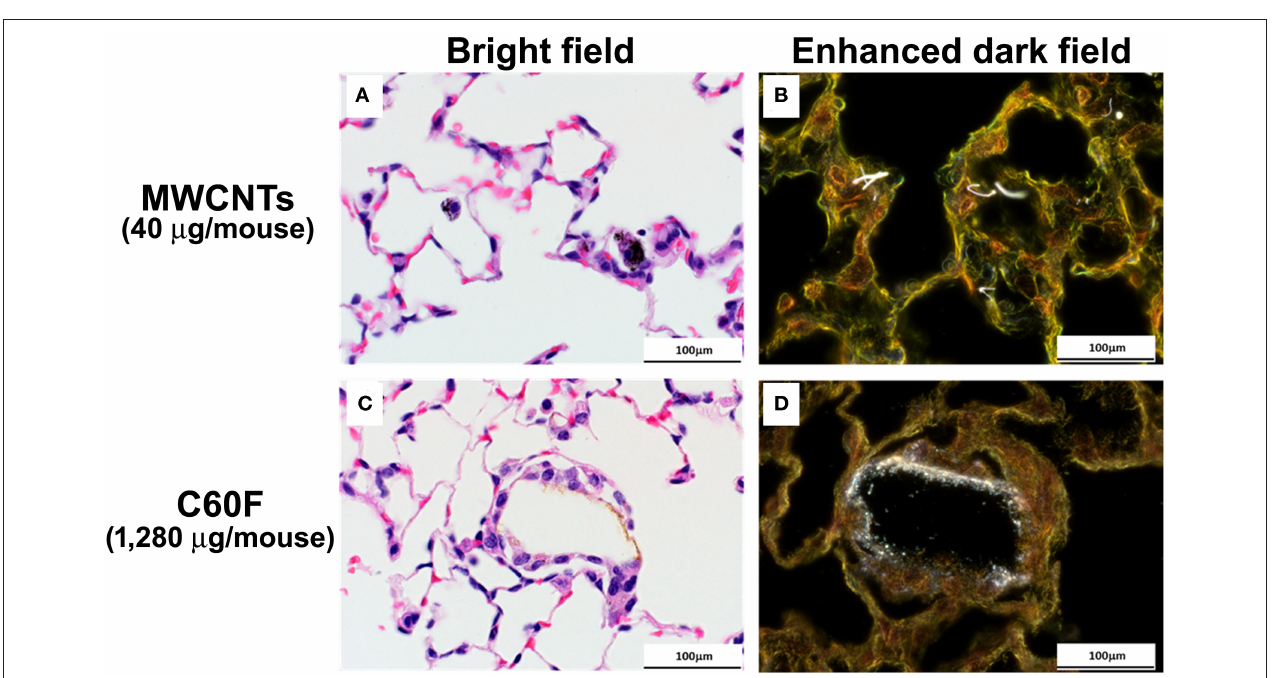
FIGURE 4 | Bright field and enhanced dark field microscopy demonstrating the appearance of particles in sections of mouse lung. Mice were treated as described in Figure 2 legend and the lungs were examined at 28 days post-exposure. Representative photomicrographs of H&E stained sections are shown in (A,C) . MWCNT particles appears as black spicules. Agglomerated C60F appears as a thin rim of golden-brown material surrounded by macrophages. (B,D) are representative images of Picrosirius stained lung sections imaged using enhanced dark field microscopy, confirming the presence of nanoparticles within the sections ( n = 3). Scale bar = 100 µ